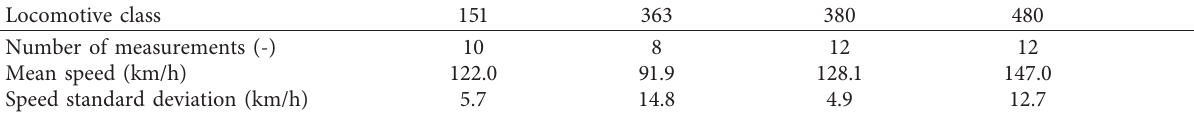
Table 3: Location 2: measured locomotives and their